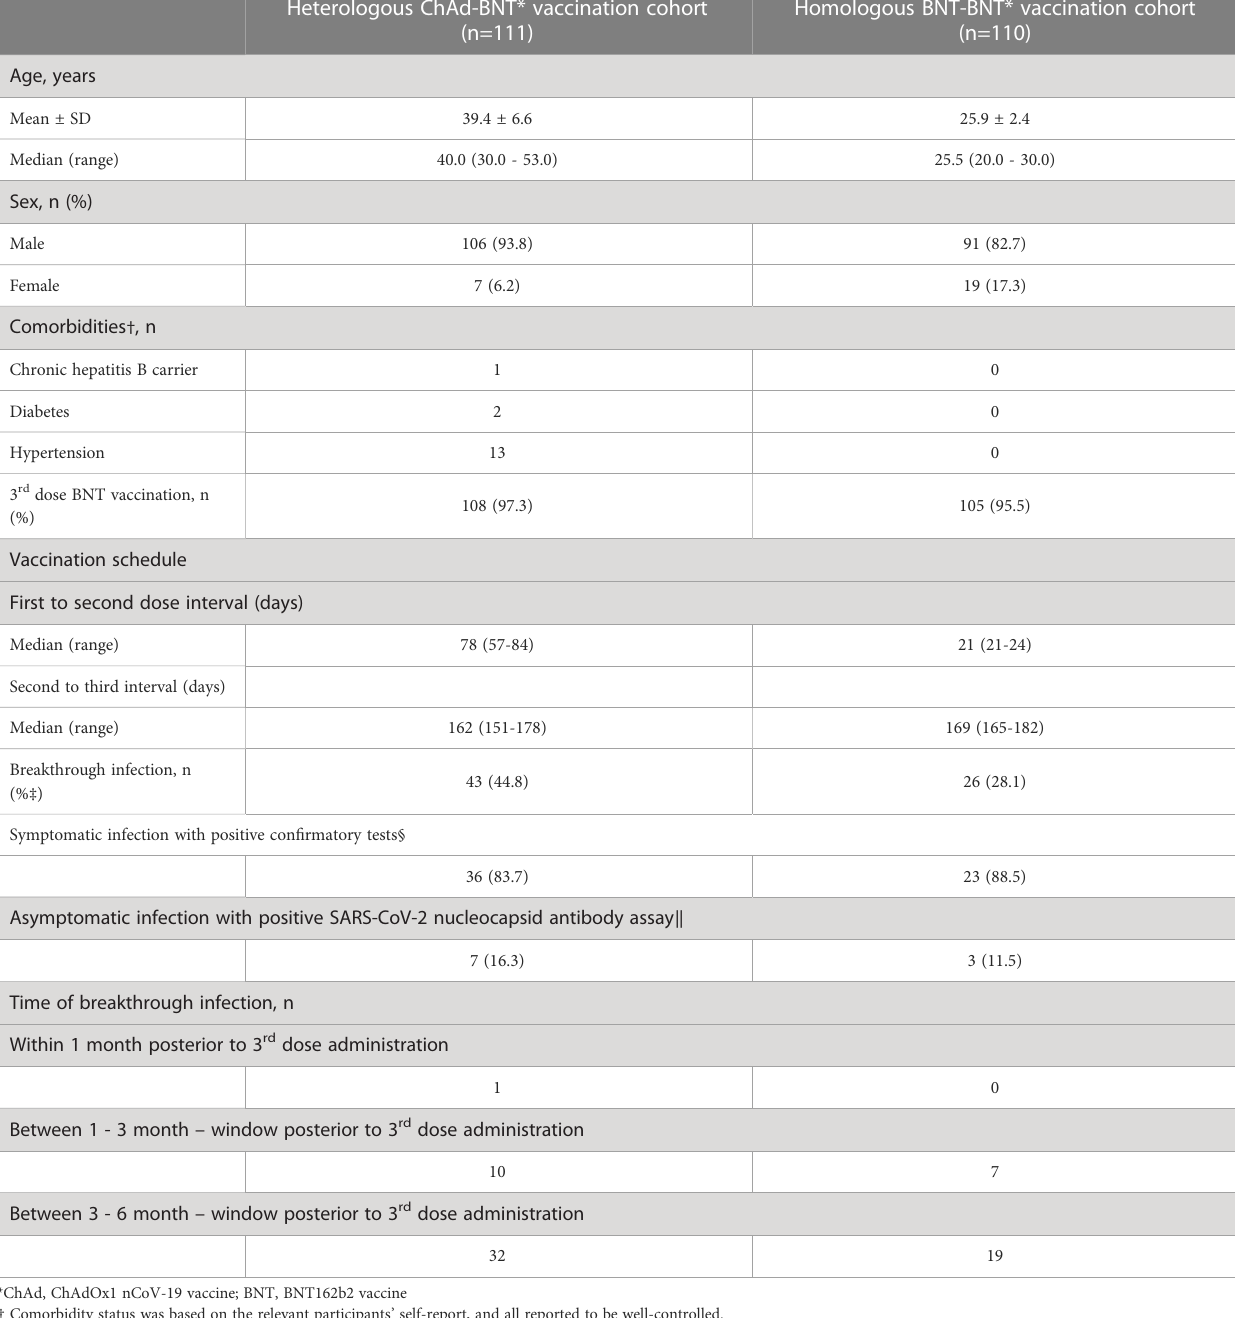
TABLE 1 Baseline characteristics of study cohorts classi fi ed by vaccine